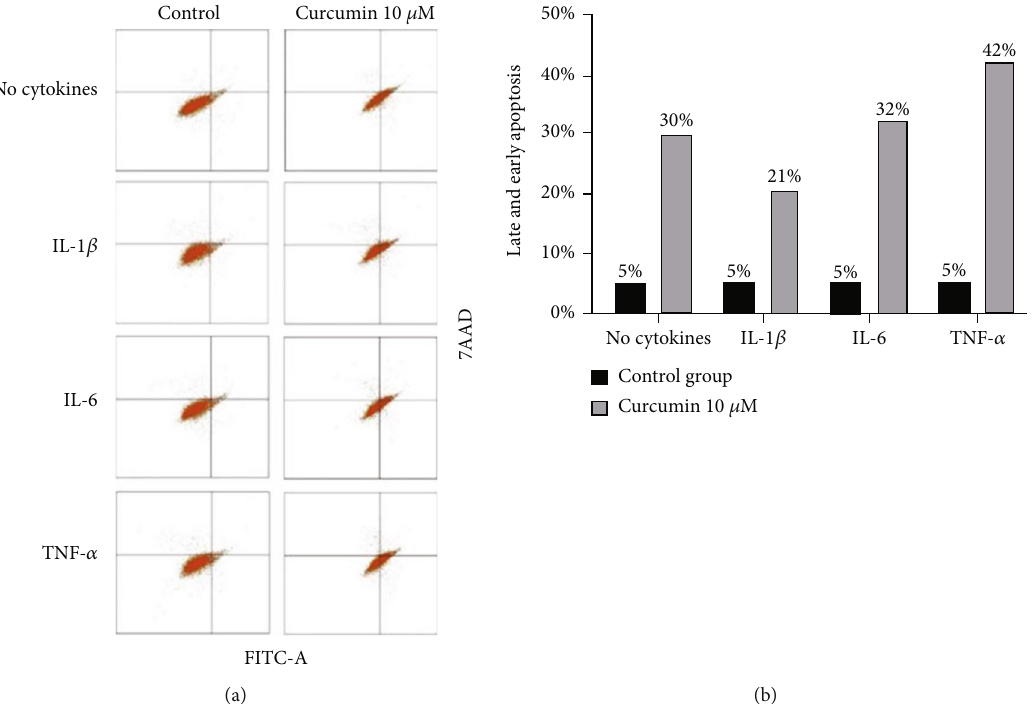
Figure 2: (a) Graphical presentation of representative data from fl ow cytometric analysis of apoptosis after 24 h cell incubation with curcumin (10 μ M) and cytokines (50 ng/ml). x -axis: intensity of FITC-A fl uorescence. y -axis: intensity of 7-AAD fl uorescence. Dot plots present alive cells: lower left; early apoptotic cells: lower right; late apoptotic cells: upper right; and dead cells: upper left. After treatment, the cells were stained using Annexin-FITC/7-AAD Kit and were measured by fl ow cytometry. (b) Bars represent the percentage of total apoptotic cells (early+late apoptosis) in cytokine-stimulated cells and control